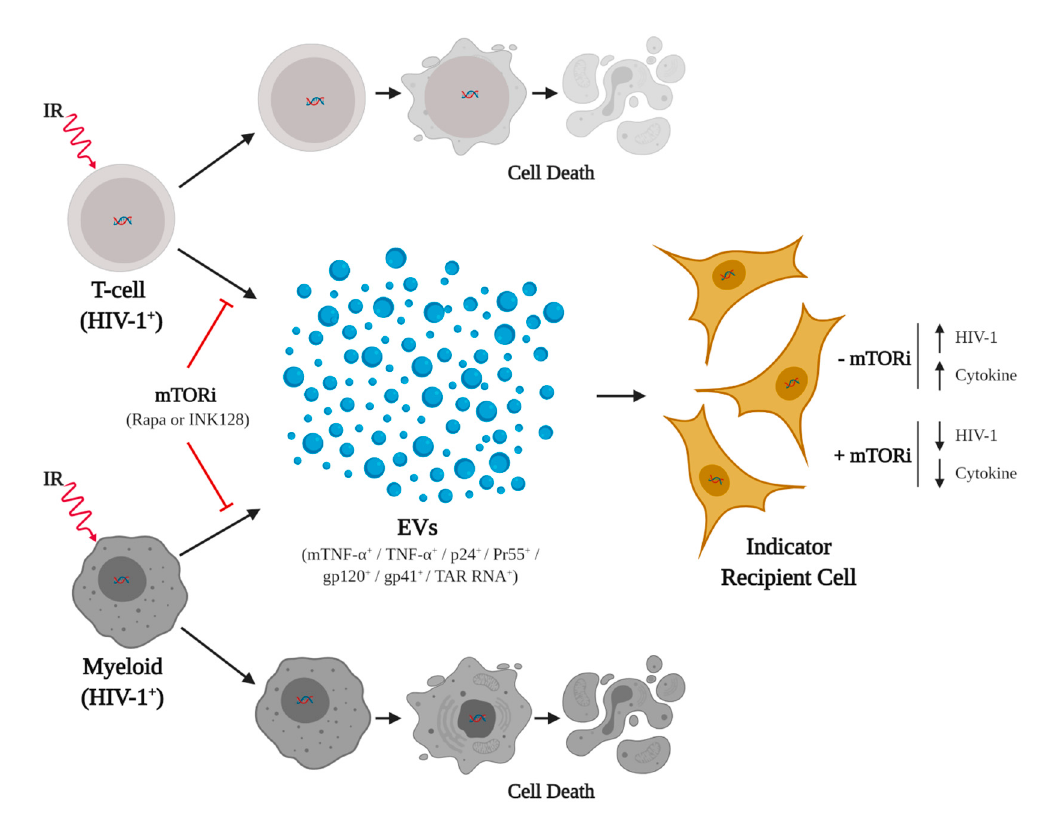
Figure 7. Combination of cART, Starvation, IR, and mTORi drugs suppress the effects of TNF- α and viral proteins on recipient cells. The HIV-1-infected myeloid and T-cells, located in latent reservoirs, persist despite cART pretreatment. Ionizing radiation (IR) activates HIV-1 and induces cellular stress, which leads to cell death, with increased resilience in myeloid cells. The infected cells also secrete EVs associated with pro-inflammatory cytokines (i.e., mTNF- α and TNF- α ) and viral molecules (i.e., p24, Pr55, gp120, gp41, and TAR RNA) with adverse effects on neighboring recipient cells. Drugs that inhibit mTOR (i.e., Rapa and INK128), along with serum starvation, suppress the release of cytokines and viral molecules, preventing LRA related side effects. Figure created with BioRender.com.